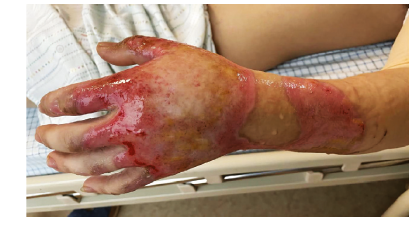
Figure 6: 7d after